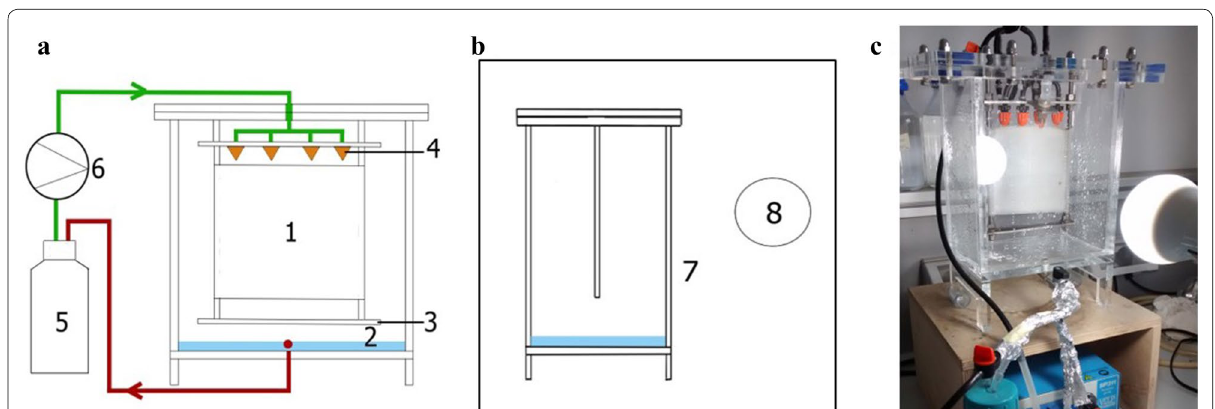
Fig. 1 Biofilm PBR design: a PBR front view, b PBR side view and c PBR photograph. (1) Cotton carrier (for attachment of microalgae), (2) synthetic wastewater, (3) carrier holder, (4) dropper, (5) reservoir of synthetic growth medium, (6) pump, (7) PBR side view and (8) LED